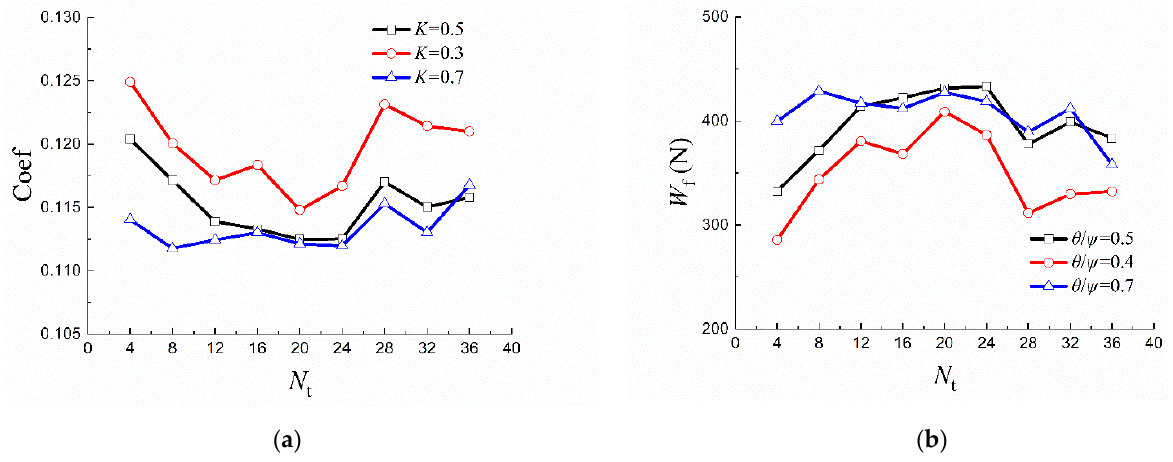
Figure 5. ( a ) Friction coefficient and ( b ) hydrodynamic load-bearing capacity varying with N t .